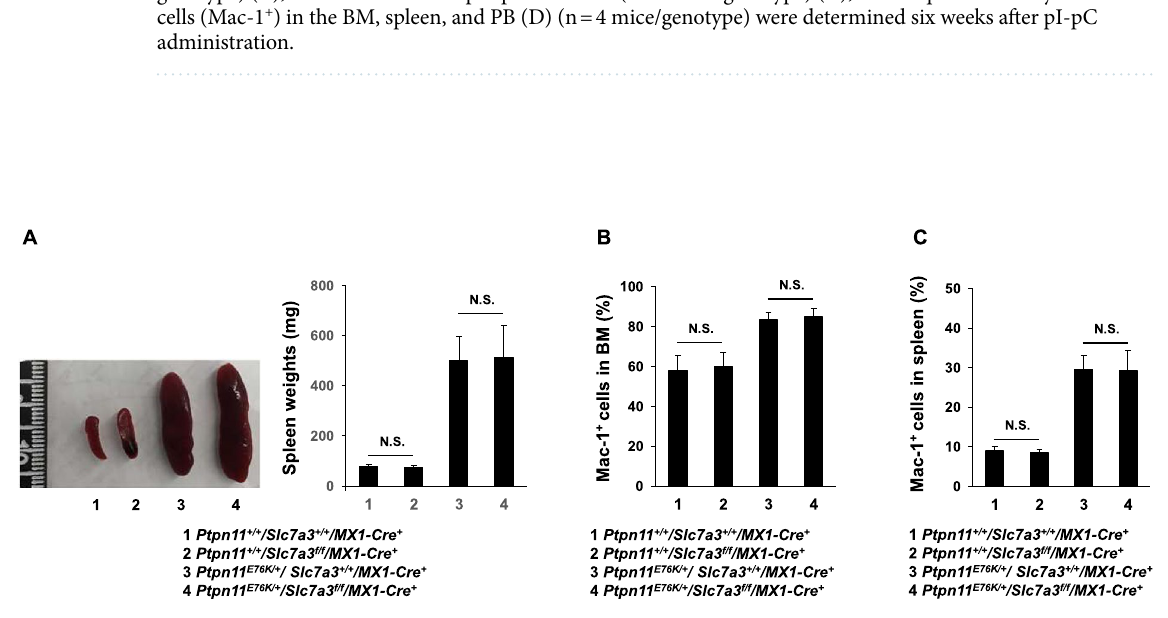
Figure 5. Leukemogenesis driven by the oncogenic Ptpn11 E76K mutation is not affected by Slc7a3 depletion. Six to eight-week-old Pten f/f /Slc7a3 f/f /MX1-Cre + , Pten f/f /Slc7a3 + / + /MX1-Cre + , Pten + / + /Slc7a3 f/f /MX1-Cre + , and Pten + / + / Slc7a3 + / + /MX1-Cre + mice were administered pI-pC to induce the oncogenic Ptpn11 E76K mutation and deletion of Slc7a3 . Spleen weights (normalized against body weights) ( A ), frequencies of myeloid cells (Mac-1 + ) in the BM ( B ) and spleen ( C ) were determined 9 weeks after pI-pC treatment (n = 4